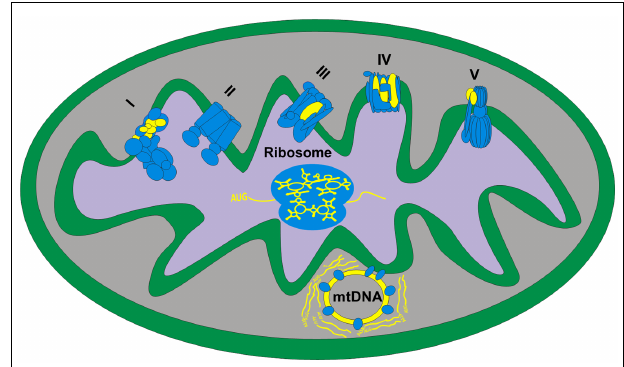
FIGURE 1 | Human mitochondrial systems require cooperation of nDNA and mtDNA-encoded factors – an illustration of a single mitochondrion. Shown are the five OXPHOS complexes, the mitochondrial ribosome and the mtDNA with its adjacent proteins and RNA products, representing the replication and transcription systems. Blue objects – nDNA-encoded proteins that are imported into the mitochondria. Yellow objects – mtDNA-encoded elements including the mtDNA itself, mitochondrial RNAs and the mtDNA-encoded OXPHOS complexes’ subunits. I–V: OXPHOS protein complexes.The physical location of the mtDNA and ‘cloud’ of synthesized mRNA is based on our interpretation of recent high resolution microscopy investigation of the mitochondrial nucleoid, i.e., the mtDNA-protein structure that encompasses the replication and transcription machineries (Brown etal.,